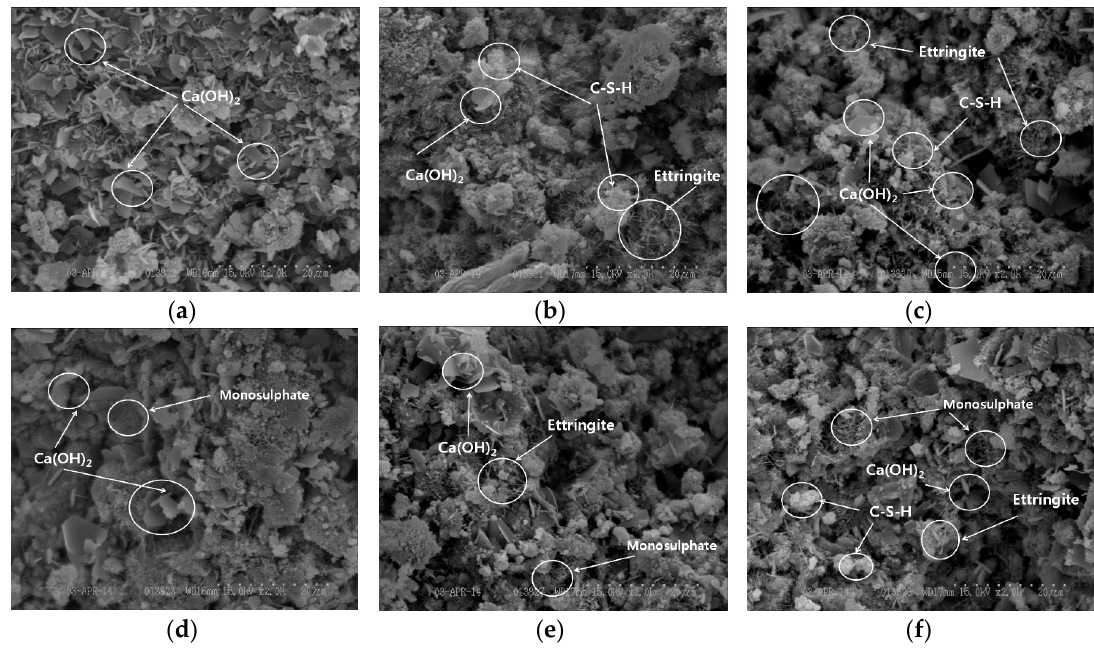
Figure 15. Result of the measurement of OGE as a function of aging time at different ESA burning temperatures (×2000 magnification). ( a ) OPC (one day); ( b ) OGE 1 (one day); ( c ) OGE 2 (one day); ( d ) OPC (three days); ( e ) OGE 1 (three days); ( f ) OGE 2 (three days).